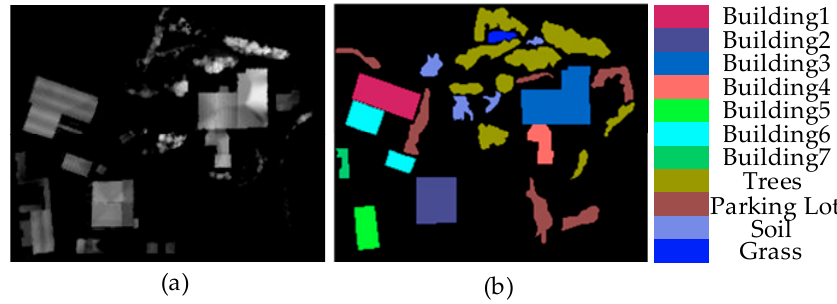
Figure 6. Recology data set: ( a ) DSM map; ( b ) Groundtruth map.